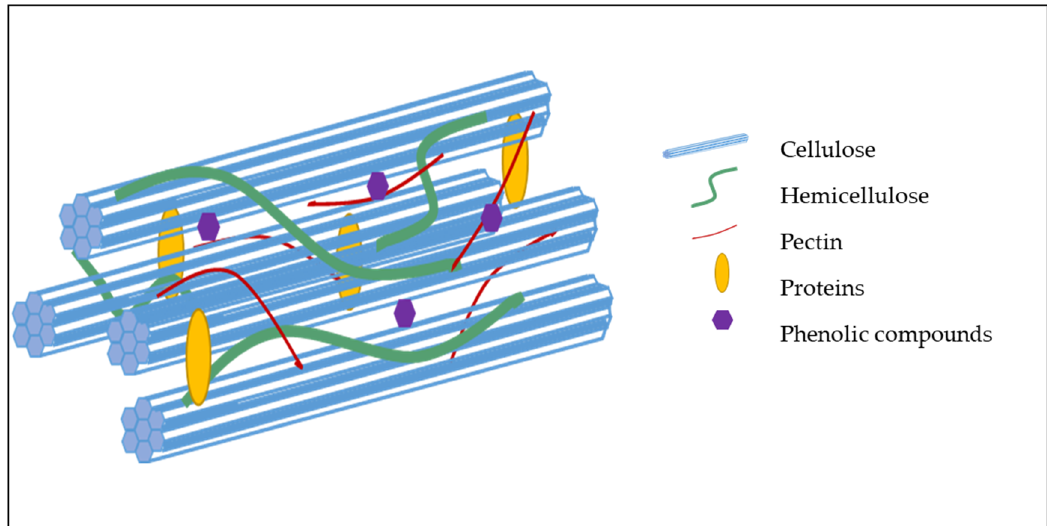
Figure 3. Schematic representation of the structure of a primary cell wall (no lignin) and organization of its constituents.